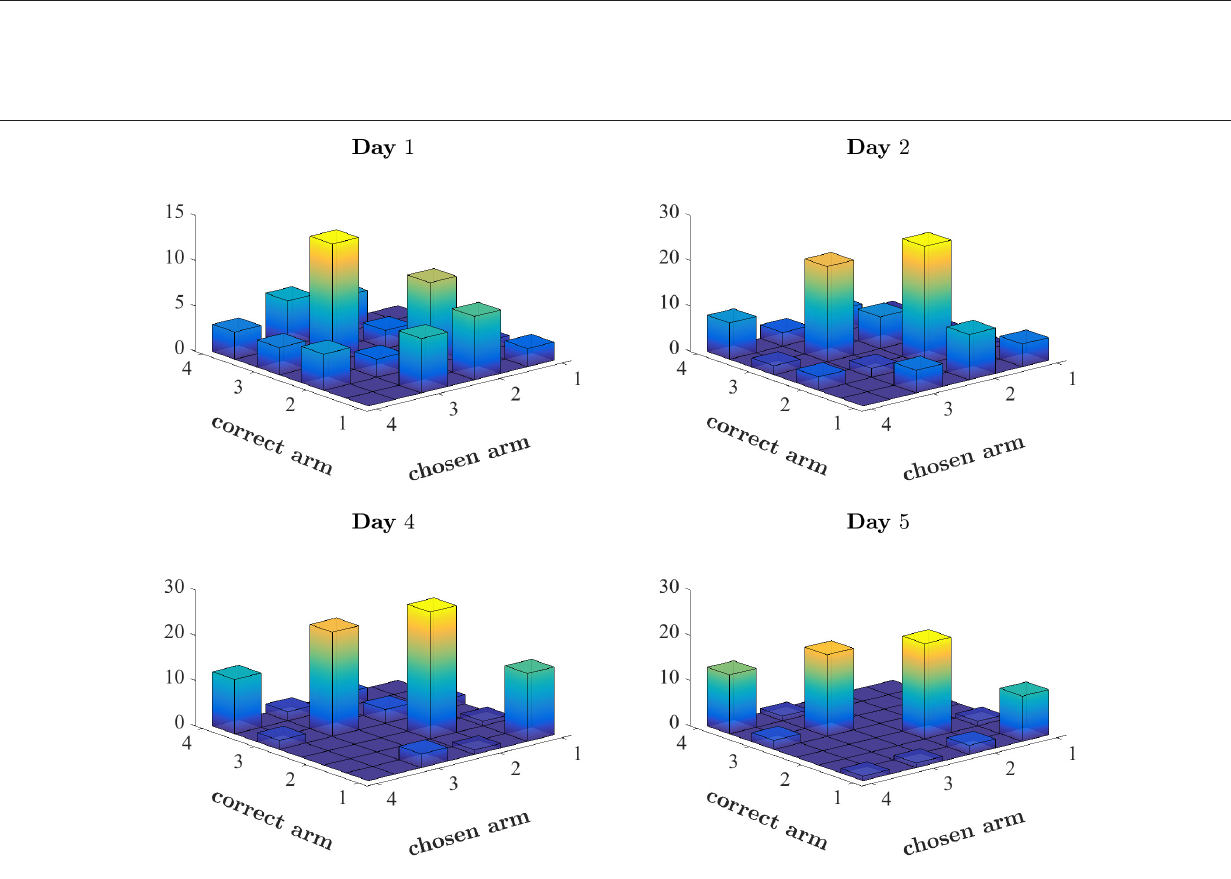
FIGURE 3 | Pattern of choices made by a single rat. Number of times the rat chose each arm, plotted against the correct arm in the trial. Correctly performed choices appear on the diagonal. Spatial bias appears as disproportionate number of choices of a single arm (see for example the choices of arm 3 on Day 1). The first 2 days and the last 2 days of the first set of this rat (ODOR 1) are